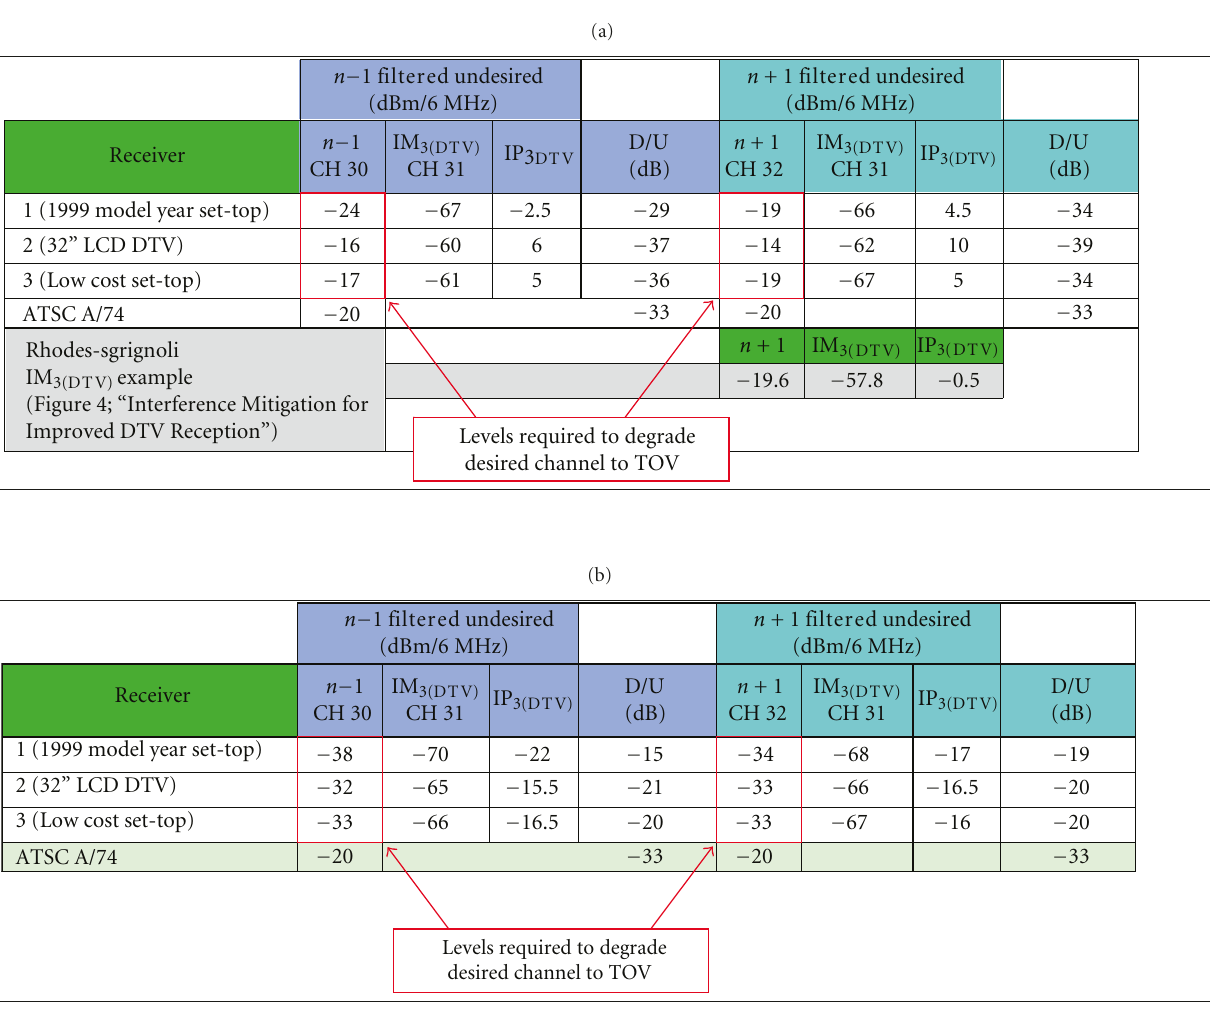
Table 3: (a) Desired channel power = − 53 dBm/6MHz; undesired signal with minimum IM 3(DTV) ; (b) desired channel power = − 53dBm/6MHz; undesired signal with significant IM 3(DTV)